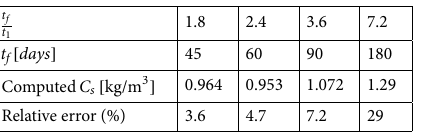
Table 1. Recovered injected concentration for different final time with t 1 = 25 days and l 1 = 5 days ( C s exact = 1 kg/m 3 ).